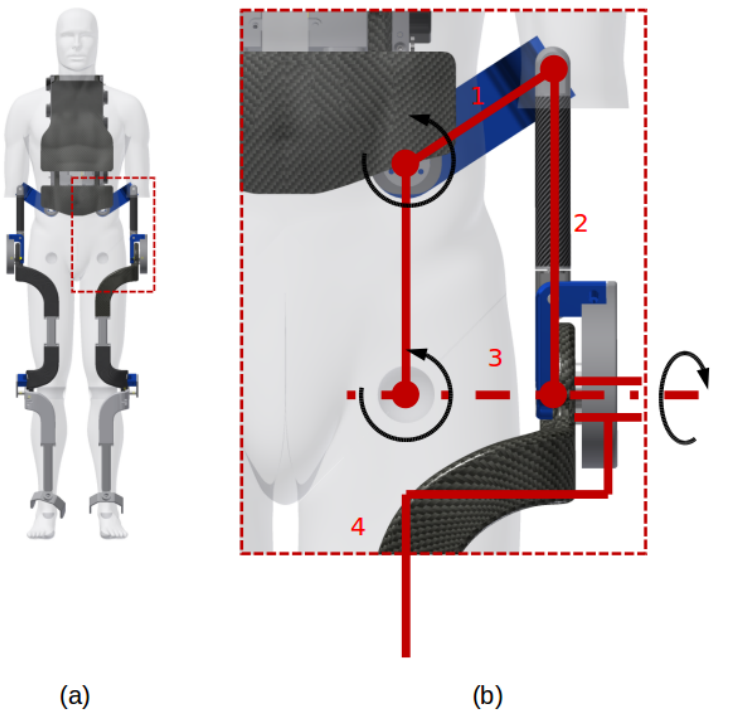
Figure 2. CAD model: ( a ) exoskeleton attached to the trunk and lower limbs; ( b ) detailed view of links and